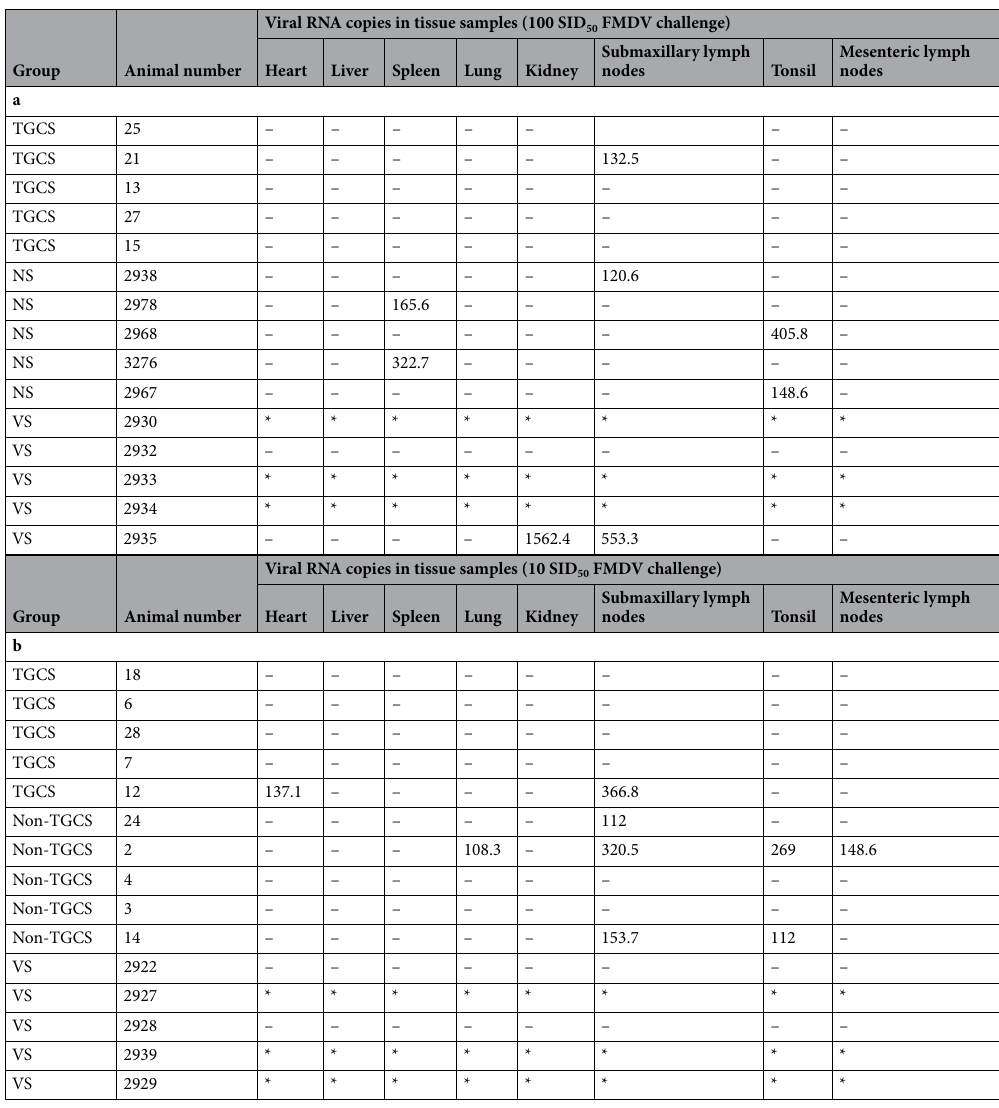
Table 1. The viral RNA load was reduced in the TGCS tissues after necropsy. Eight different tissues were collected from the swine challenged with 100 SID 50 (a) and 10 SID 50 (b) of FMDV and were analyzed for the viral RNA load by one-step qRT-PCR. The numbers in the columns are the viral RNA copy numbers detected by one-step qRT-PCR.“–” indicates that the viral RNA load in the sample was not detectable. “*” indicates that the sample was not